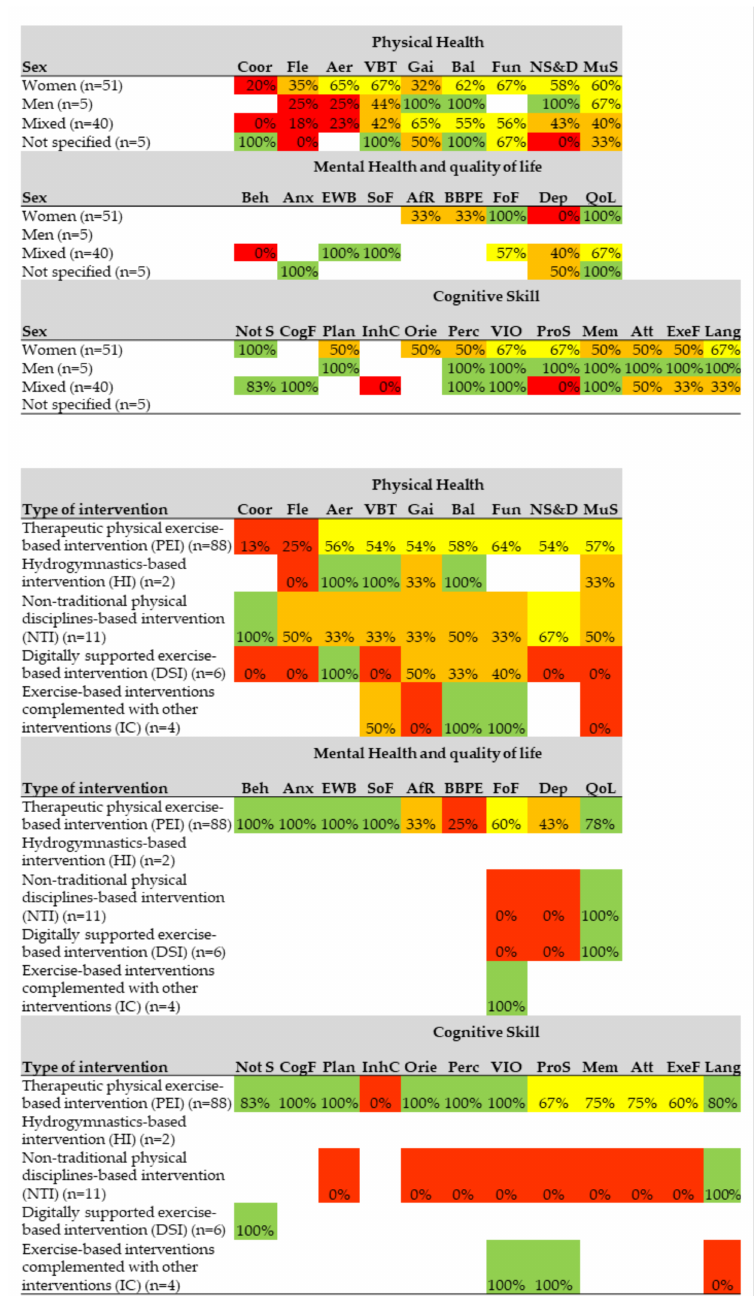
Figure 5. Effects by sex and by type of intervention on the outcomes of physical health and quality of life, mental health and cognitive skills. The percentage of articles that present significant effects on each health outcome measures is shown. 0–25% red, 26–50% orange, 51–75% yellow, 76–100% green and white: no studies. Physical health Coor: Coordination, Fle: Flexibility, Aer: cardiorespiratory fitness, VBT: Vital signs, blood tests and others, Gai: Gait; Bal: Balance, Fun: Functionality, NS&D: Nutritional status and diet, MuS: Muscular strength. Mental health and quality of life: Beh: Behavior, Anx: Anxiety, EWB: Emotional well-being, SoF: Social functions, AfR: Affective response, BBPE: Barriers and Benefits Perceived for the Execution of the Exercise, FoF: Fear of falling, Dep: Depression, QoL: Quality of life. Cognitive skills Not S: Not specific, CogF: Cognitive flexibility, Plan: Planning, InhC: Inhibitory control, Orie: Orientation, Perc: Perception, ViO: Visuospatial orientation, ProS: Processing speed, Mem: Memory, Att: Attention, ExeF: Execution Function, Lang: